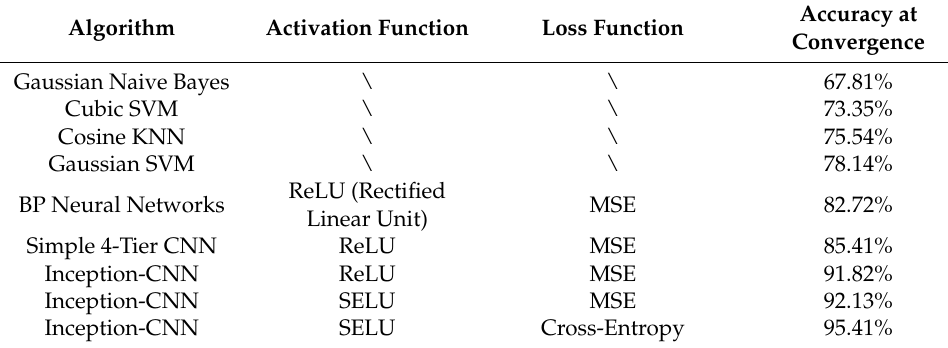
Figure 9. Accuracy changes during some neural networks’ training. Table 3. Performance comparison of Inception-CNN and other